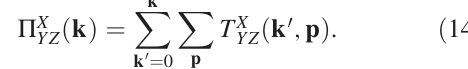
FIG. 3. Iso-contours (in logarithmic scale) of the bi-dimensional L velocity energy spectrum E u L ð k ⊥ ; k spectrum E b R ð k ⊥ ; k Þ (right) corresponding to Run I (top) and II k